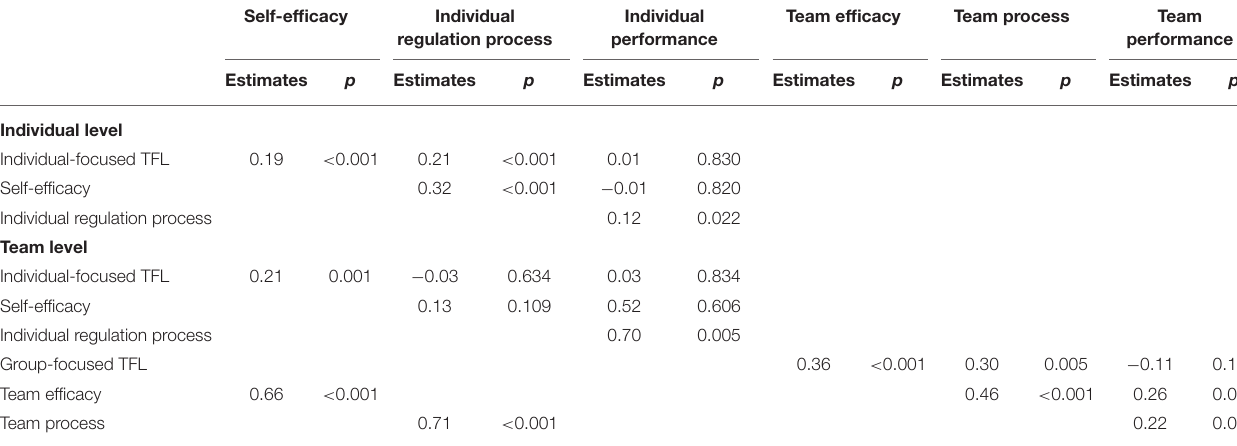
TABLE 4 | Unstandardized estimates of direct effects without control